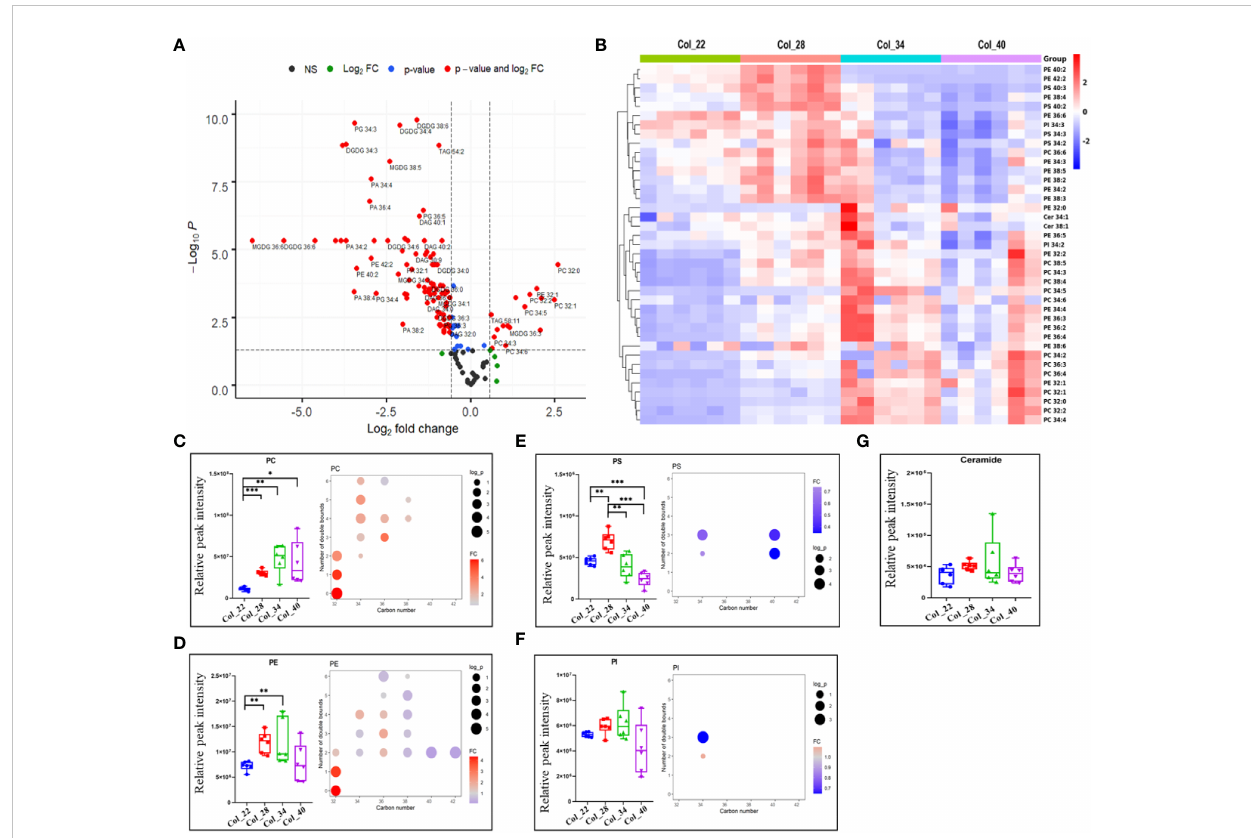
FIGURE 3 Comparative analysis of lipidome for Arabidopsis seeds germination/seedling growth under four temperature conditions. (A) The distinguished alteration of lipids between moderate (22°C, 28°C) and extreme high temperatures (34°C, 40°C) were analyzed by volcano plot. X-axis was Log2 fold change and the y-axis was – Log10 P value. The red dots on the left indicated that lipids of seeds germination at moderate temperature signi fi cantly reduced level, compared with the extreme high temperature. The red dots on the right indicated lipids level signi fi cantly increased. Blue dots represented metabolites with only P <0.05 and green dots represent metabolites with only FC>1.5. Gray dots referred to all other identi fi ed metabolites with no signi fi cant changes between moderate and extreme high temperatures. Phosphatidic acid (PA), Phosphatidylcholine (PC), Phosphatidylethanolamine (PE), Phosphatidylserine (PS), Phosphatidylinositol (PI), Phosphatidylglycerol (PG), Diacylglycerol (DAG), Triacylglycerol (TAG), Sulfoquinovosyldiacylglycerol (SQDG), Monogalactosyldiacylglycerol (MGDG), Digalactosyldiacylglycerol (DGDG). (B) Heatmap showing Z score scaled the lipids alteration at moderate (22°C, 28°C) and the extreme high temperatures (34°C, 40°C). The relative enrichment of each lipid in different samples were arranged in rows, and the relative levels of all lipids in each sample were distributed in columns. The grids in heatmap represented lipids, and shades of color represented relative level of lipids. Red and blue colors indicate an increase and a decrease of lipid level, respectively, and white color means no change. Col_22 means seeds germinated at 22 °C, Col_28 means seeds germinated at 28°C, Col_34 means seeds germinated at 34 °C, Col_40 means seeds germinated at 40 °C. (C – G) Relative levels of phospholipid classes (small fi gure on the left of block diagram) and levels of different molecular species (small fi gure on the right of block diagram) under four temperature conditions. The FC difference was calculated as extreme high temperature group vs. moderate temperature group. Phospholipids shown as PC (B) , PE (C) , PS (D) , PI (E) and ceramide (F) . Phosphatidylcholine (PC), Phosphatidylethanolamine (PE), Phosphatidylserine (PS), Phosphatidylinositol (PI). Data are presented as mean ± SD. * P < 0.05, ** P < 0.01, *** P <